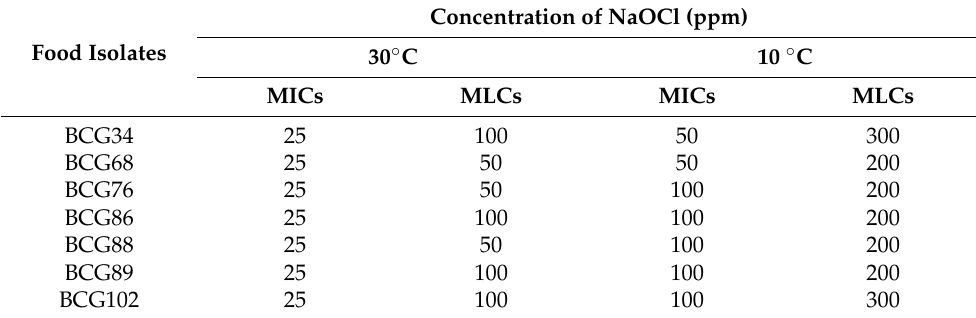
Table 1. Minimum inhibitory concentration (MICs) and minimum bactericidal concentrations (MBCs) of sodium hypochlorite (ppm) for seven psychrotolerant Bacillus cereus group (BCG) strains activated at 30 ◦ C and 10 ◦